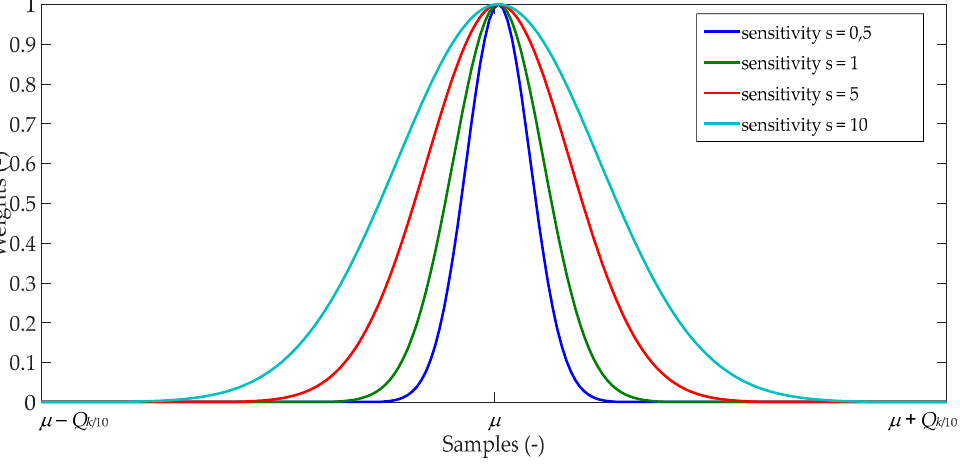
Figure 3. The assignment of weights by using the function in Equation (4) as the membership function.